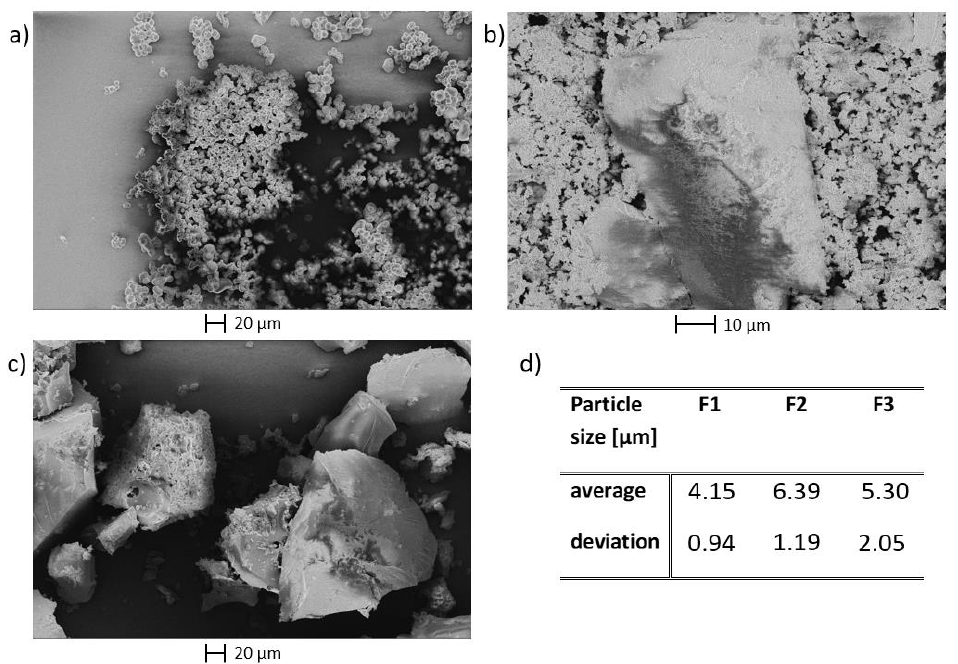
Figure 7. SEM micrographs of different humins: ( a ) F1, ( b ) F4, ( c ) F7, ( d ) average particle sizes of spherical humins.